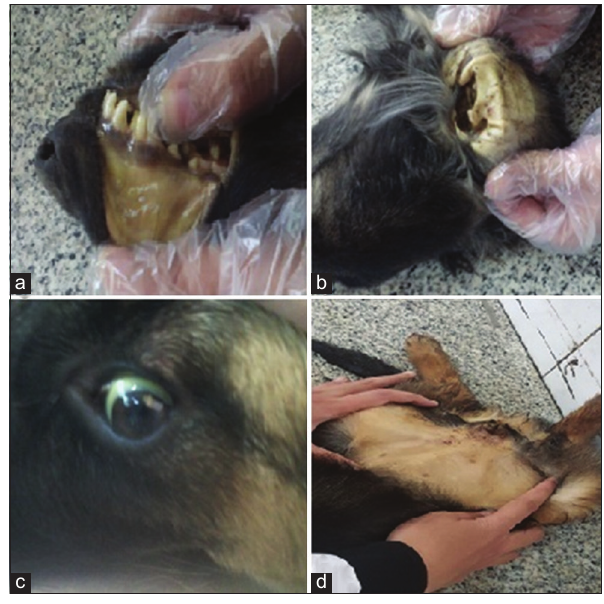
Figure-1: Clinical manifestations in Group A (acute hepatitis): (a) Icteric buccal mucous membrane. (b) Icteric inner aspect of the ear. (c) Icteric conjunctiva. (d) Icterus of ventral abdominal skin.